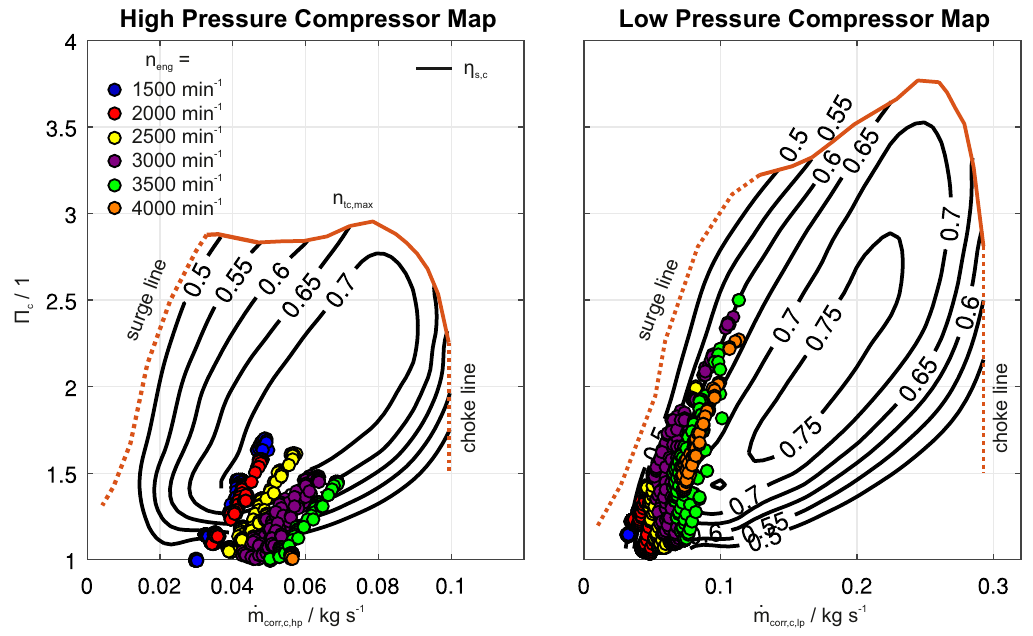
Figure 2. Compressor operating points of the low pressure and high pressure stage at different engine speeds and wastegate combinations along with